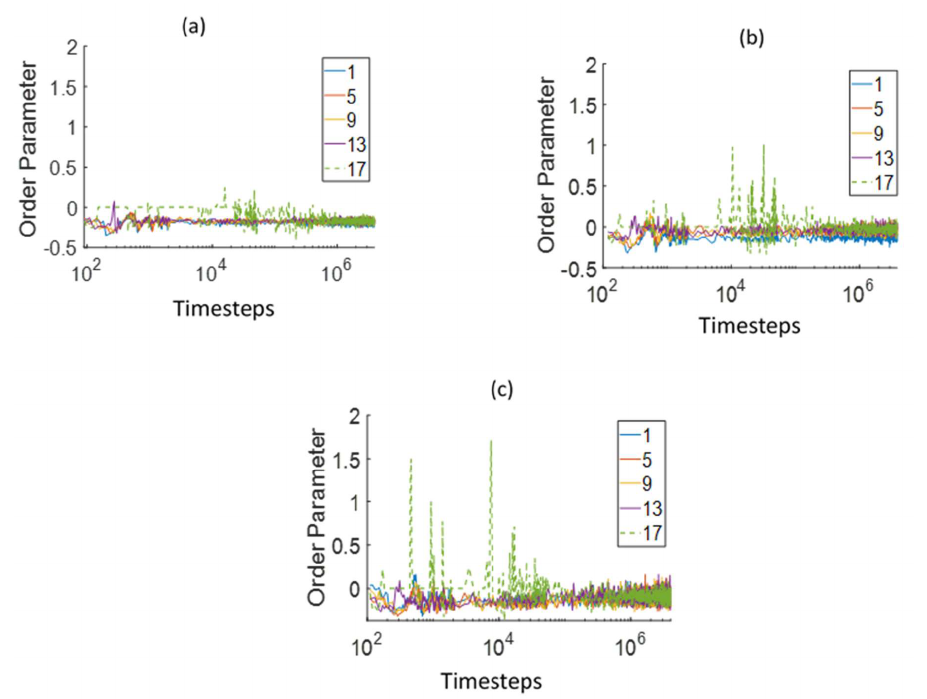
Figure 8. Comparison of the side-chain order parameter (OP) with respect to the Z-axis in different layers, at varying distances from the bottom Z boundary, for ( a ) Dow, ( b ) Nafion, and ( c ) Aciplex PEMs. Layer 1 is nearest to the bottom Z boundary and layer 17 is at the interface of water and the membrane. Each layer is 2.25 DPD units thick. The green dashed line is the OP in a layer near the water–PEM interface.